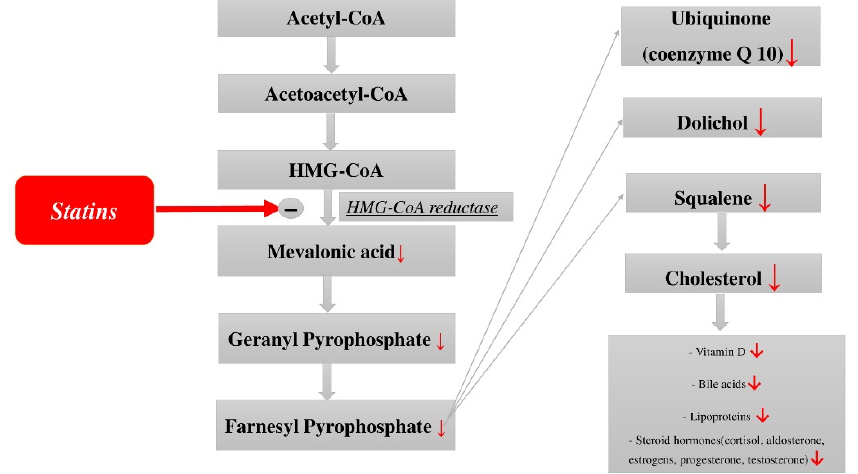
Figure 1. Scheme of cholesterol biosynthesis and its metabolites.